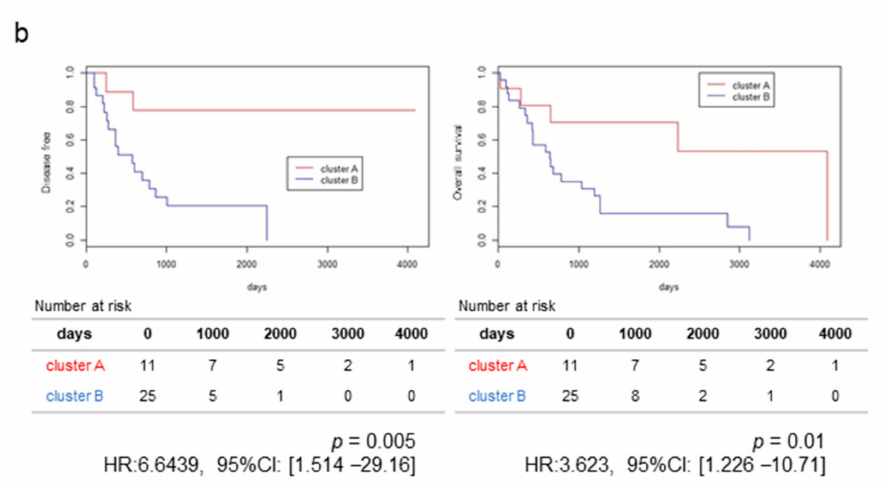
Figure 1. Molecular subclass of GBCs and their prognosis. ( a ) Hierarchical clustering analysis of the protein-coding gene expression data from 36 gallbladder cancer (GBC) samples; heatmap clustering of differentially expressed protein-coding genes. These were classified into two groups, Clusters A and B. Stromal score and immune score calculated by “Estimate” correlated with these clusters. ( b ) Kaplan–Meier plots of disease-free survival (left) and overall survival (right) of resected GBC cases. Significant differences in the prognosis between Clusters A and B are observed ( p = 0.01 and 0.005 by log-rank test, respectively, and HR: 6.6439, 95% CI (1.514–29.16) and HR: 3.623, 95% CI (1.226–10.71)). Each table in the bottom shows numbers at